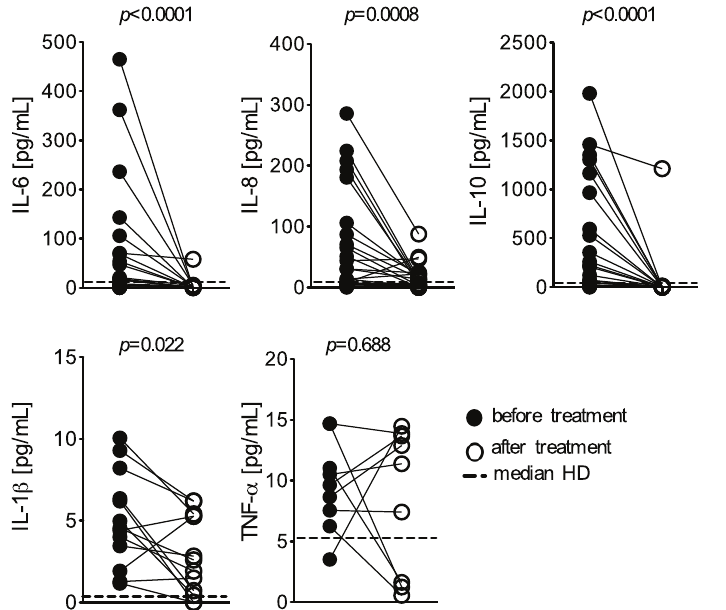
Figure 1. High levels IL-1 b IL-6, IL-8 and IL-10 in plasma from patients infected with P.vivax . The cytokines IL-8 (CXCL8), IL-1 b , IL-6, IL-10, TNF- a were measured in the plasma of P. vivax -infected subjects (n=26), before (closed circles) and 30–45 days after treatment (open circles). Dotted lines represent medians of given measurements from healthy donors (HD; n=13). Levels of cytokines were measured employing the Cytometric Bead Array (CBA). Significant differences are indicated with p -values using Wilcoxon signed rank test when the data failed the normality test.